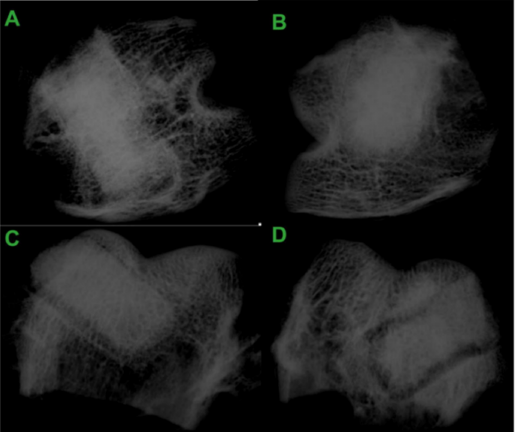
Figure 8. Radiographs of extracted rabbit distal femurs: ( A ) 6C3G1L300-MBP, ( B ) 6C3G1L300-SDBP, ( C ) 6C3G1L600-MBP, ( D ) 6C3G1L600-SDBP. Reprinted from [67] with permission from